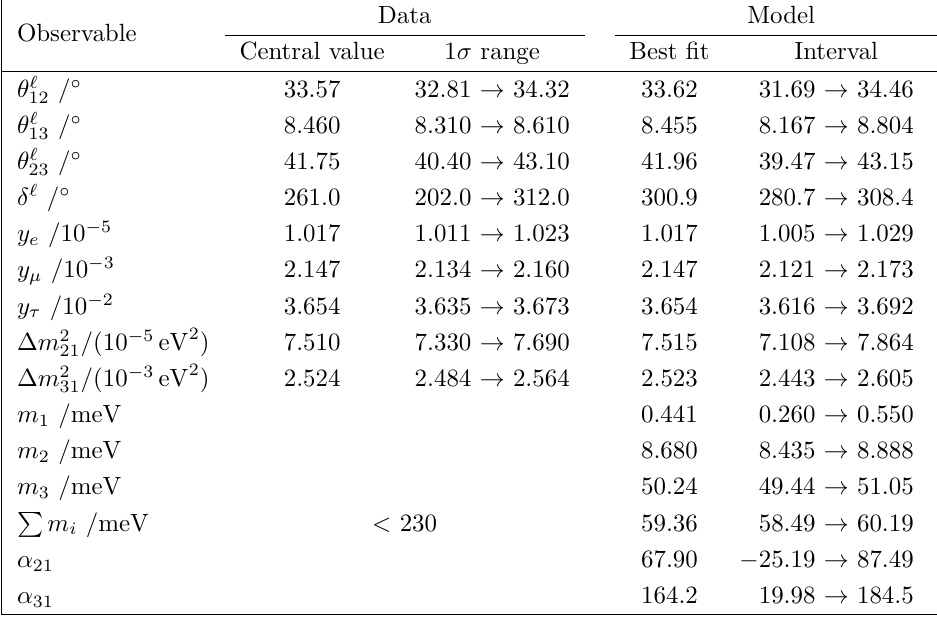
Table 2 . Model predictions in the lepton sector for tan (cid:12) = 5, M SUSY = 1 TeV and (cid:22) (cid:17) The observables are at the GUT scale. The lepton contribution to the total (cid:31) 2 is 0.03. (cid:14) ‘ as well as the neutrino masses m i are pure predictions of our model. The model interval is a Bayesian 95% credible interval. The bound on P m i is taken from